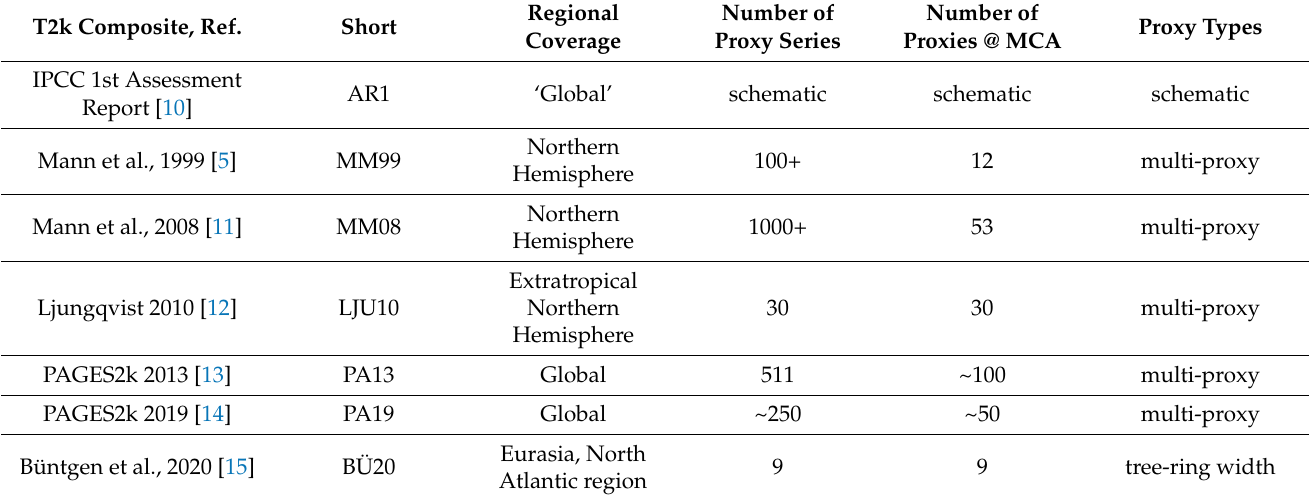
Table 1. Proxies and regional coverage of the seven T2k composites compared in this analysis. Multi- proxy comprises of speleothems, ice cores, long historical records, corals, varves, tree-ring maximum latewood density (MXD), tree-ring width, lake and marine sediments, pollen, and biological or physical processes that can be used to reconstruct temperature